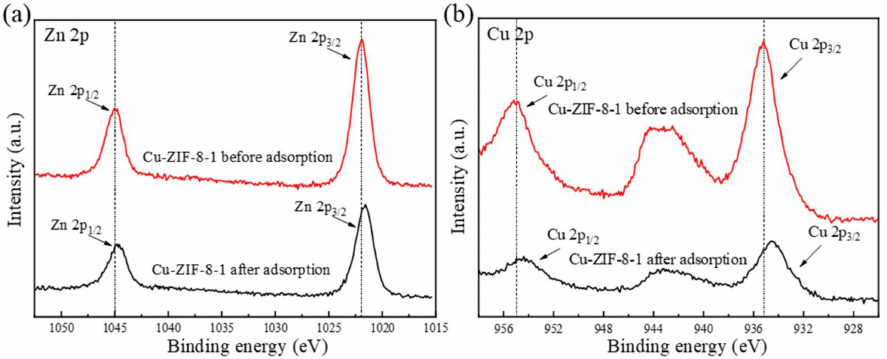
Figure 9. XPS spectra of Zn ( a ) and Cu ( b ) in Cu-ZIF-8-1 before and after adsorption ( c 0 = 200 mg · L − 1 ).